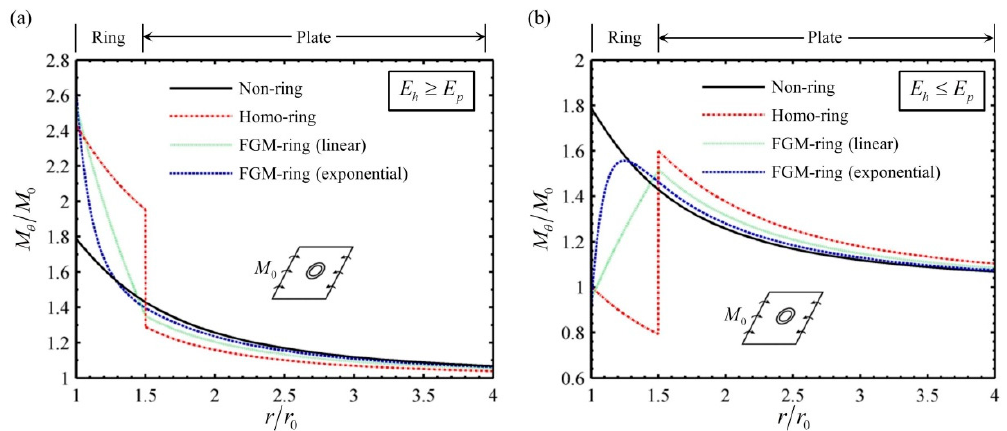
Figure 6. Distribution of moments M θ / M 0 along the radial direction ( θ = ± 90 0 ) for di ff erent types of ring: ( a ) E h = 1.5 E p ; ( b ) E h = 0.5 E p